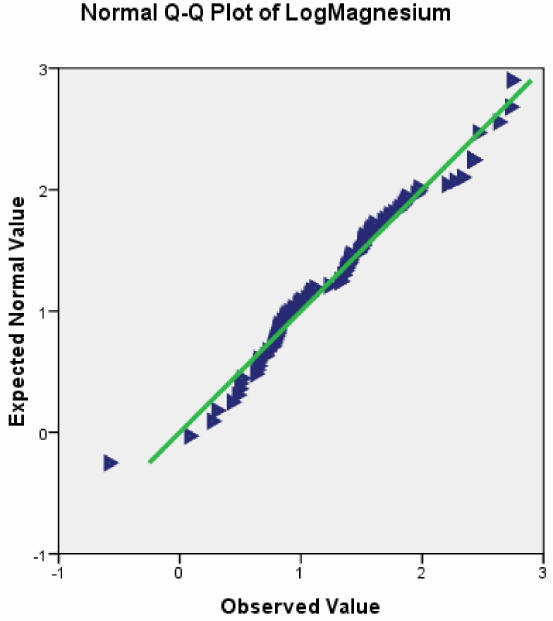
Figure 3. Q-Q plot after log transformation for